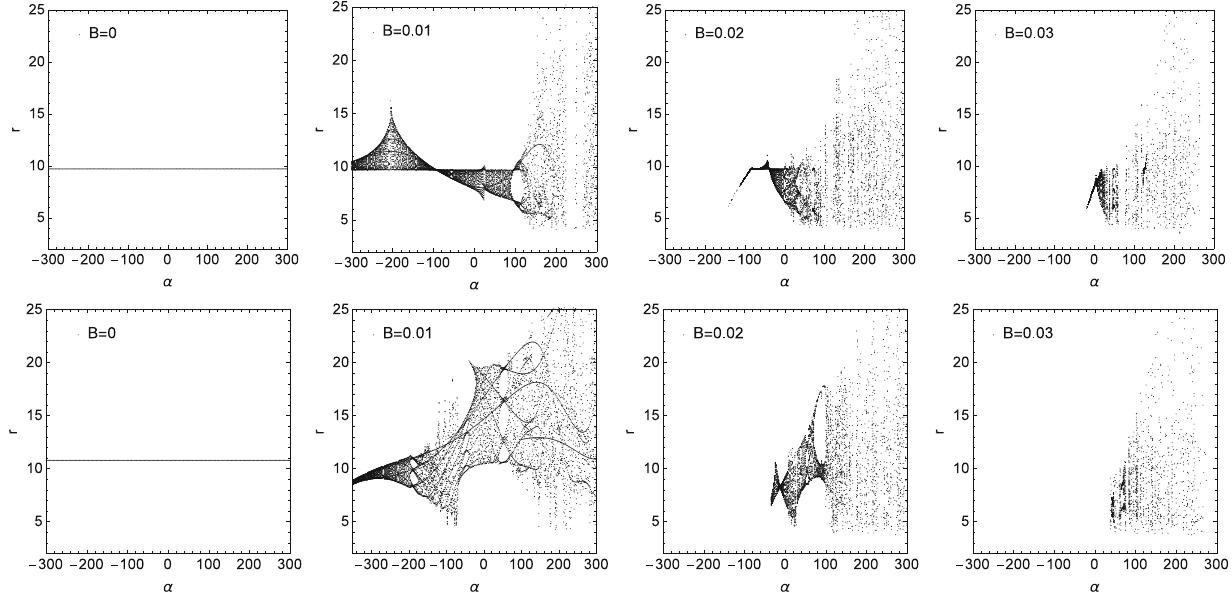
Fig. 8 The bifurcation diagram with coupling parameter α for different B in the Schwarzschild–Melvin black hole spacetime. The set of initial conditions for the graphics are { r ( 0 ) = 9 . 7 ; ˙ r ( 0 ) = 0 ; θ( 0 ) = π